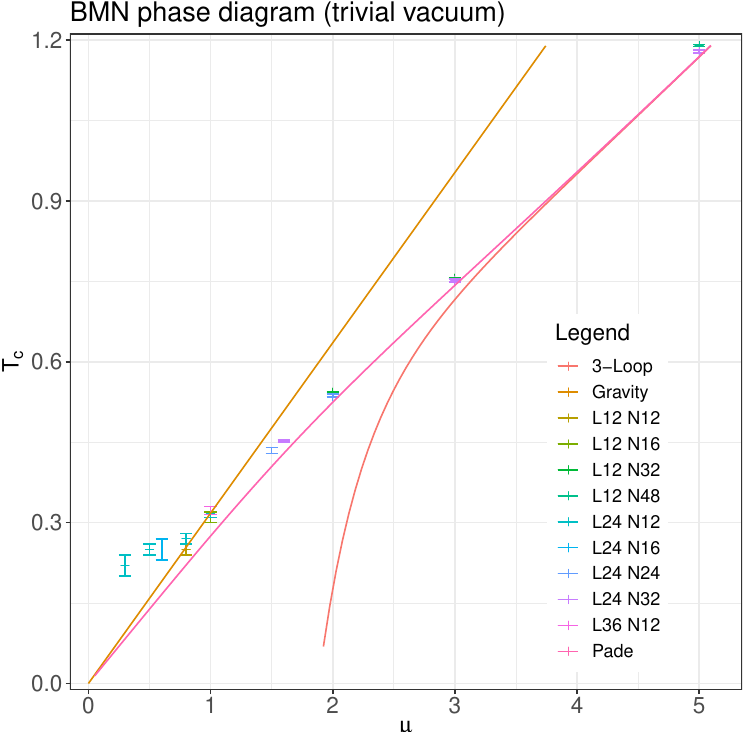
Figure 13. The critical temperature T c vs. flux parameter µ for the full BMN model. The data points for the critical temperature correspond to a two-state signal with about equal probability for confined and deconfined phase, and their error bars are given by the neighboring simulated temperatures, for which these probabilities differ. The error bars without data points for µ = 0 . 6 indicate observation of a hysteresis, see figure 25. For µ = 1 . 5 and 1 . 6 , we also observed hystereses in the region given by the error bars but did not investigate the full extent of the hysteresis region. For comparison, the prediction of the perturbative analysis [40], Padé resummation [47], and gravity calculation [39] are plotted. In the main text, the way the transition temperature at each parameter set is determined is detailed, and the apparent deviation from the gravity predictions at small µ is explained. (Note that the latter can simply be a finite- N artifact.) In the BFSS limit µ → 0 , although we could not identify the two-state signal, we still conclude that we observe the confined phase; see section